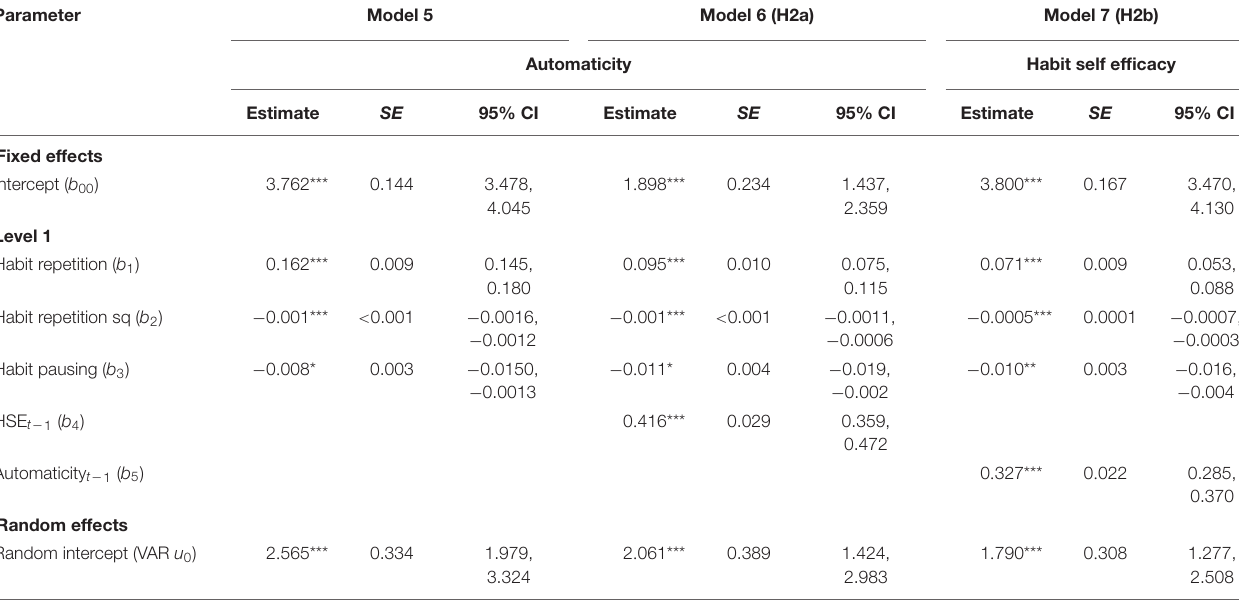
TABLE 2 | Virtuous-cycle-models of automaticity on habit-specific self-efficacy based on real-life app user data.